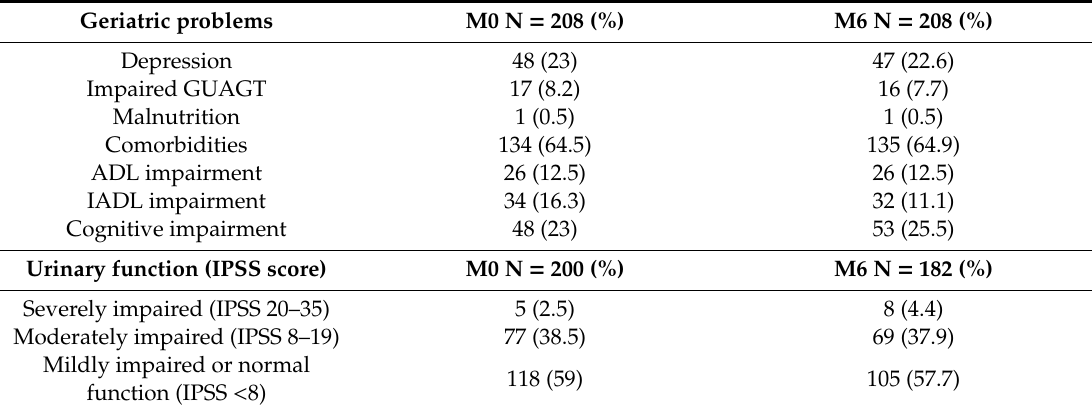
Table 2. Urinary and geriatric impairments over